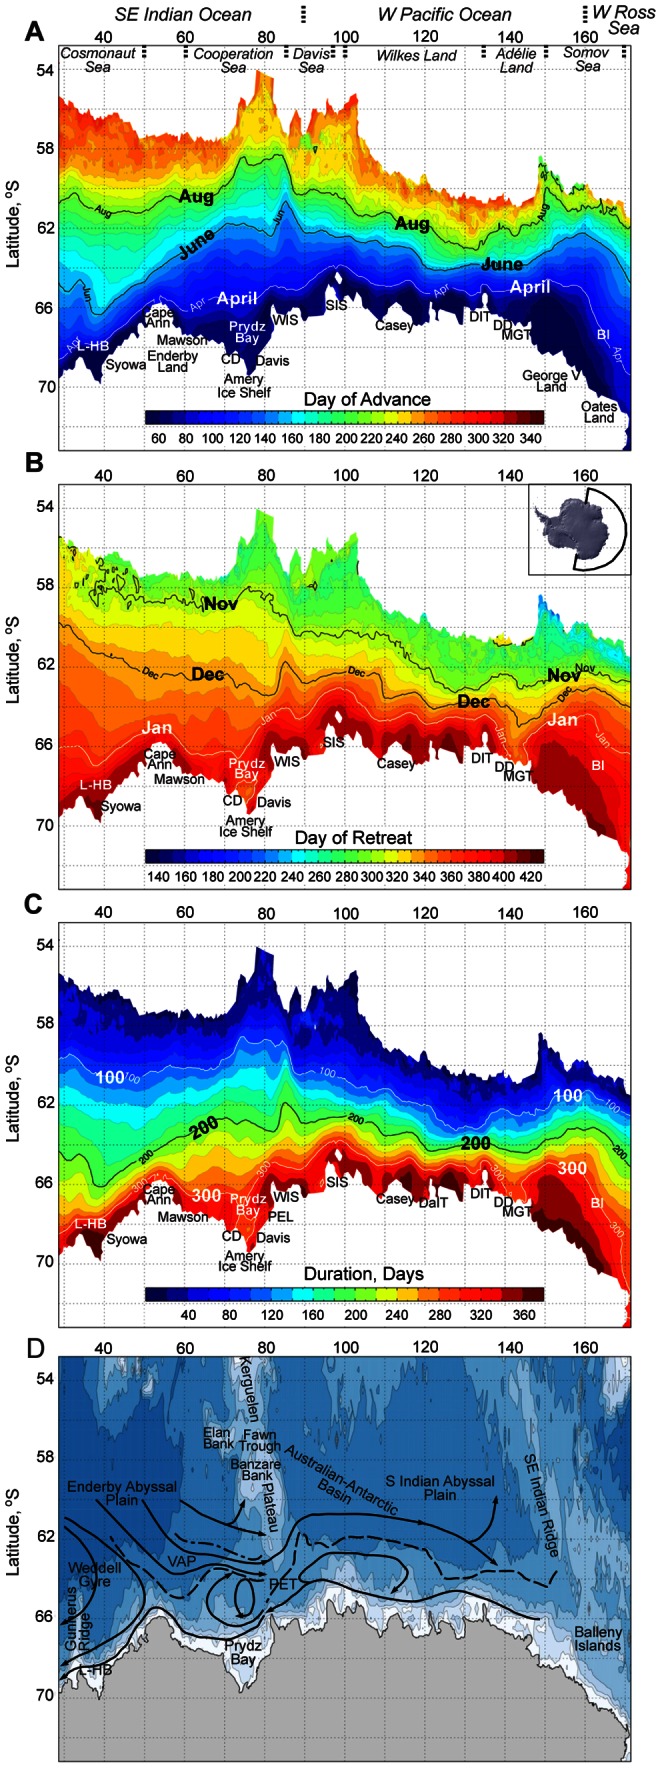
Climatological patterns of East Antarctic sea ice seasonality, 1979/80–2009/10.A) Mean days of sea ice advance, with contours for April, June and August marked. Place names used in the text are also marked: L-HB is Lützow-Holm Bay, CD Cape Darnley, PEL Princess Elizabeth Land, WIS West Ice Shelf, SIS Shackleton Ice Shelf, DaIT Dalton Iceberg Tongue, DIT Dibble Iceberg Tongue, DD Dumont d'Urville, MGT Mertz Glacier Tongue, and BI Balleny Islands). B) Mean days of sea ice retreat, with contours for November to January marked, and an inset of the study region. C) Mean ice season duration, with contours for 100, 200 and 300 days marked. D) Ocean bathymetry (contours at 500, 1000, 2000, 3000, 4000 and 5000 m), with a cartoon superimposed of the large-scale ocean circulation patterns in the sector determined from hydrographic measurements (after [28]). The dashed lines indicate the location of the SB-ACC, and the dash-dotted line that of the Southern Antarctic Circumpolar Current Front, VAP Valdivia Abyssal Plain, and PET Princess Elizabeth Trough. Numbers along the x axes are degrees longitude east.